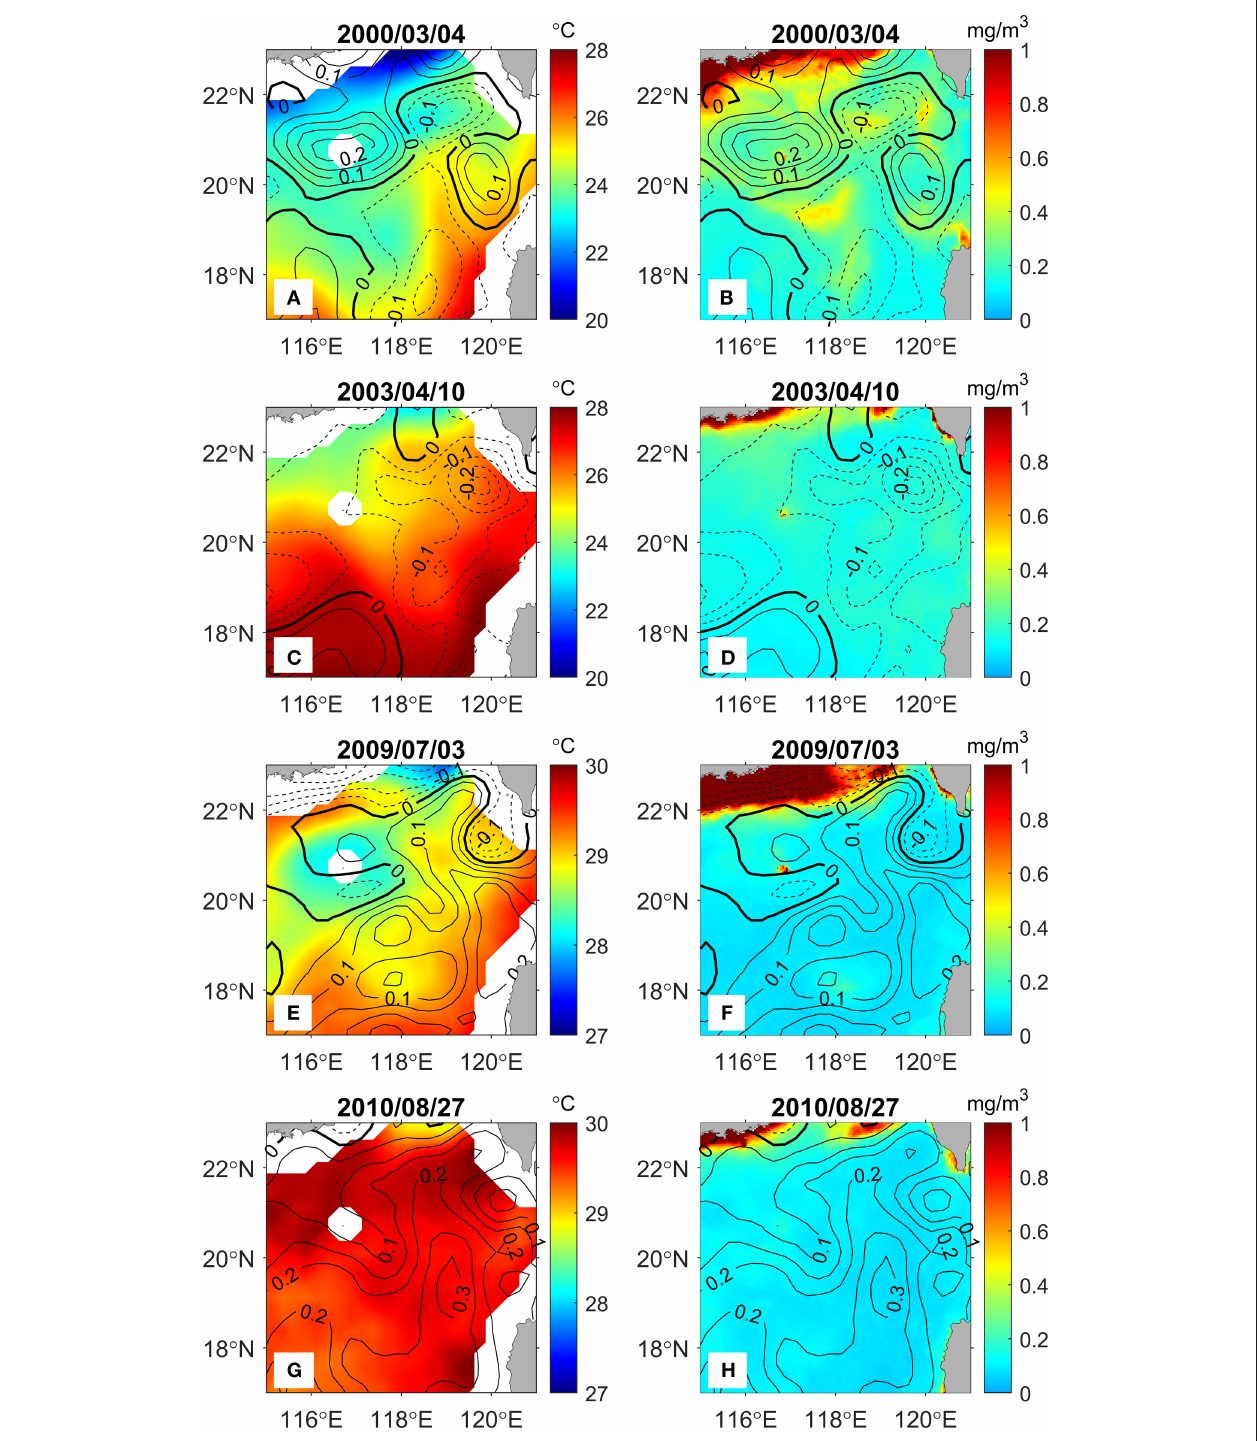
FIGURE 7 | (Left) Spatial distribution of SST on March 4, 2000, April 10, 2003, July 3, 2009, and August 27, 2010. (Right) Same as the left-panel subfigures but are for the chlorophyll-a (Chl) distribution.